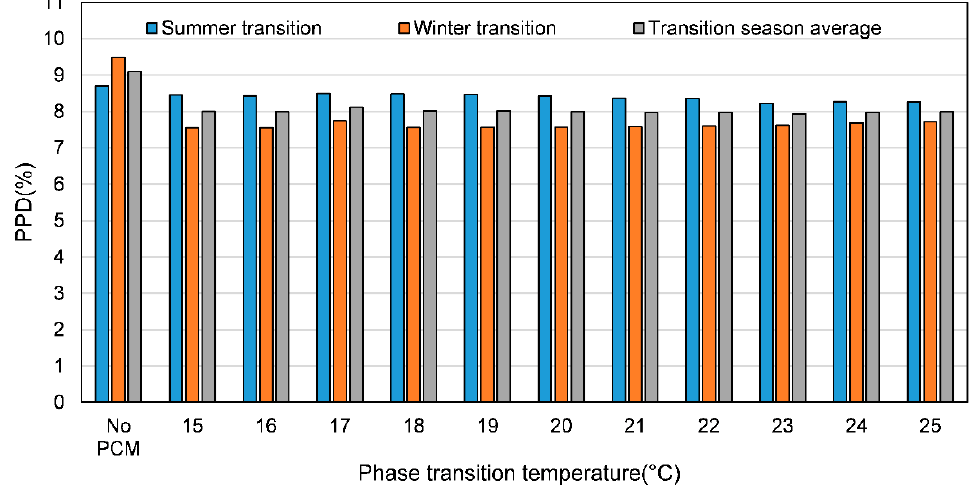
Figure 14. The predicted percentage of dissatisfied (PPD) of the models with different PCM phase change temperatures in transition seasons.